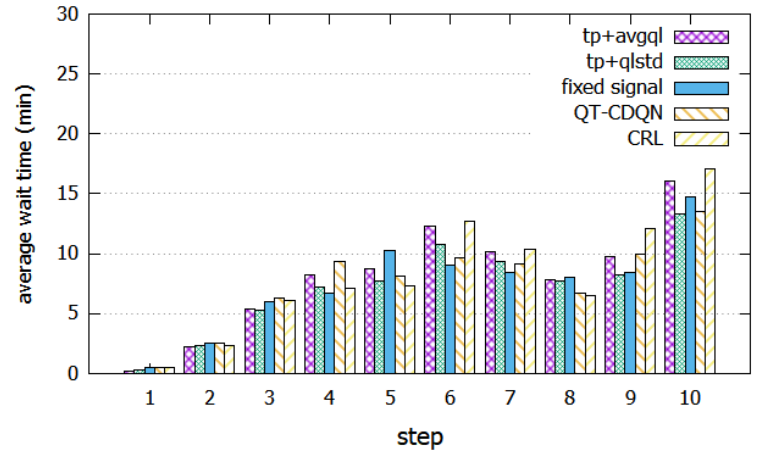
Figure 11. Performance comparison: average wait time.